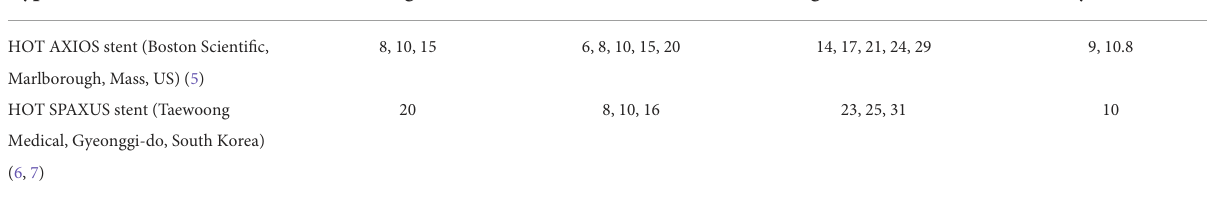
TABLE 1 Current electro-cautery lumen apposing metal stent on market. Types of